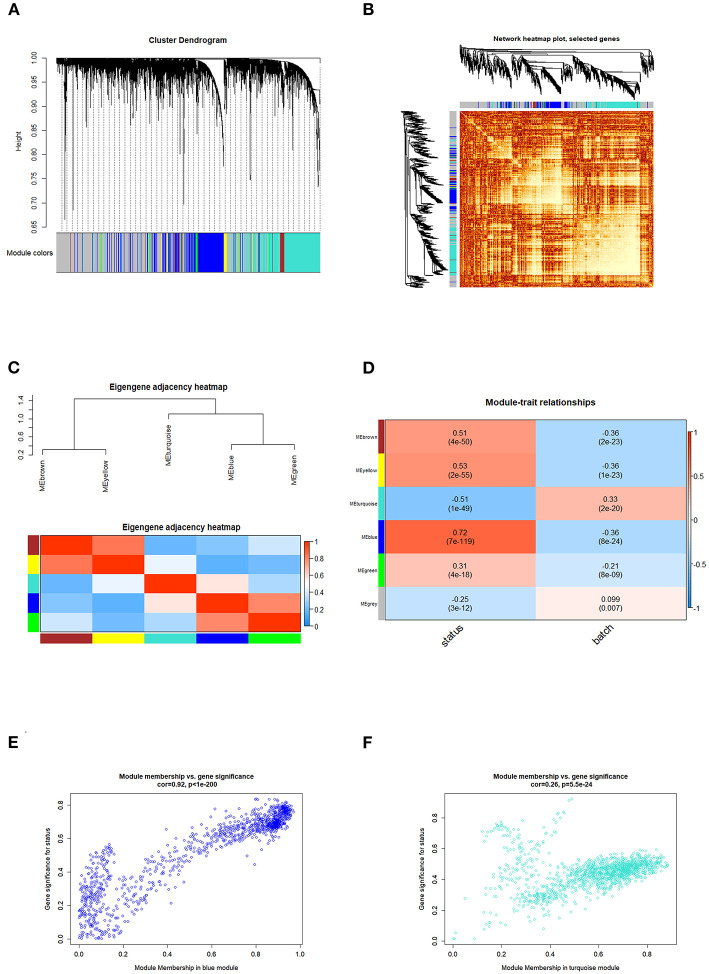
WGCNA analysis identified the gene modules related to RA. (A) The dendrogram showed that the molecules were classified into different gene modules based on the correlation analysis. Different colors represented the different modules, and the gray module represented genes that were unassigned to any network. (B) The network heatmap showed the correlation of genes in different modules, and the lighter areas represented the higher correlation. (C) Eigengene adjacency heatmap showed that aside from relatively strong correlation between the blue/green or yellow/brown modules, limited correlations were observed among other module pairs. (D) The heatmap of module trait relationships showed the correlation between each gene module and clinical status of samples. The red cube represented a positive correlation, whereas the blue cube represented a negative correlation. The consensus correlation between modules and phenotypes was reported as a number shown in each cube, with p value (in parenthesis) printed below the correlations. The blue/turquoise module had the most significant positive/negative correlation with the sample status, and the scatter plots (gene significance vs. module membership) of the blue and turquoise modules were shown in (E,F), respectively.